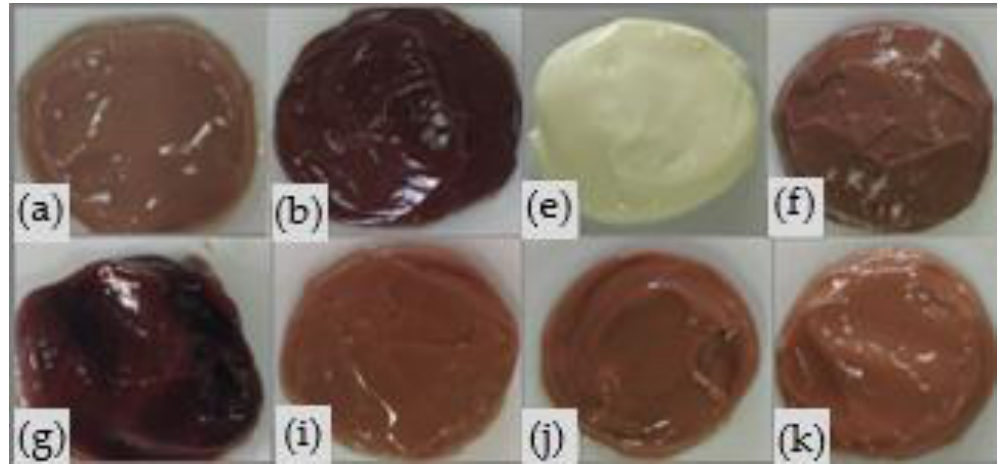
Figure 3. Topical delivery systems developed by the experimental design — DoE ( a ); ( b ); ( e ); ( f ); ( g ); ( i ); ( j ); ( k ) using grape pomace ( V. vinifera L.) and UV filters (butylmethoxydibenzoyl methane — UVA, ethylhexyl methoxycinnamate and ethylhexyl dimethyl PABA-UVB) and analyzed after 24 h of preparation.